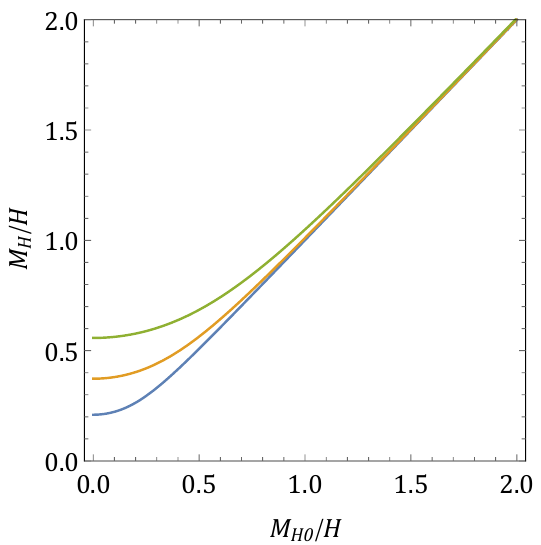
H (in unit of Hubble parameter H ) as functions